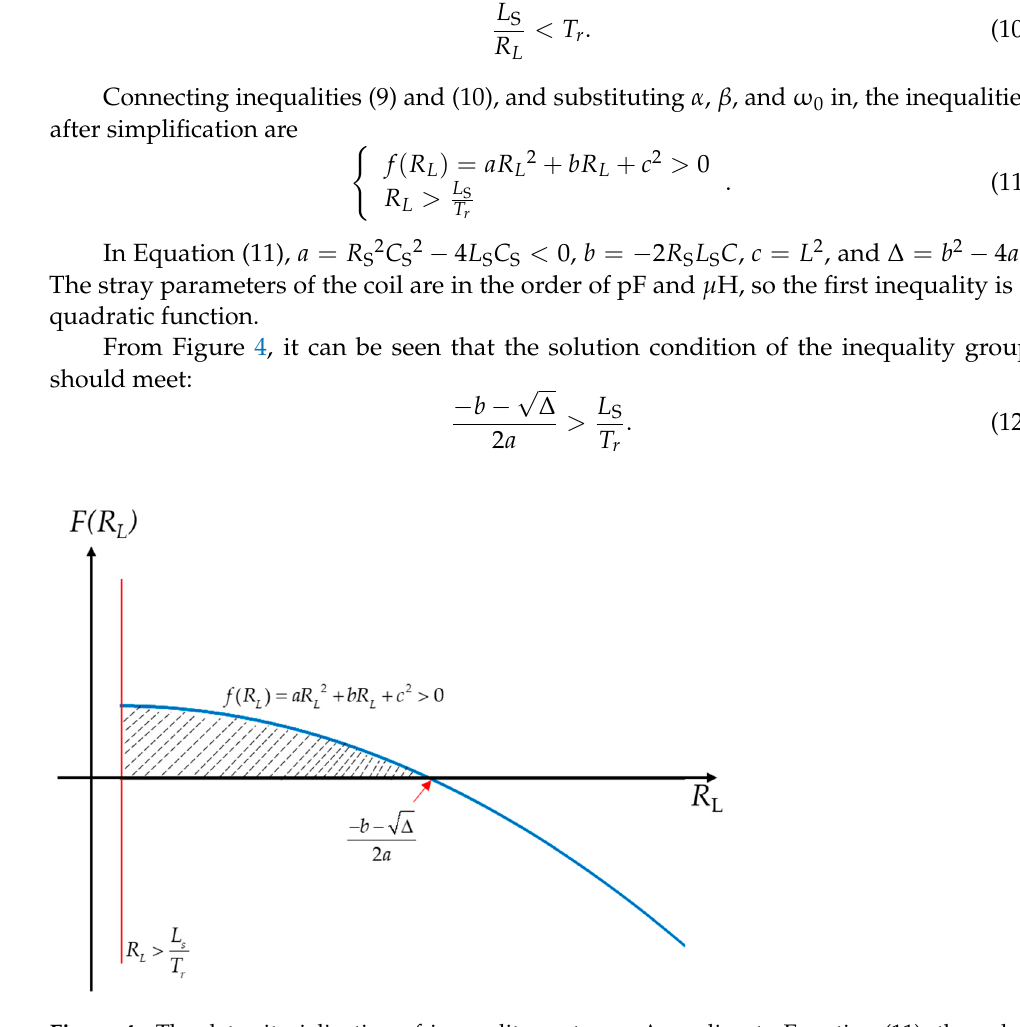
Figure 4. The deterritorialization of inequality systems. According to Equation (11), the value range of R L is within the dotted line. The red and blue lines correspond to the two constraints of Equation (11), respectively.